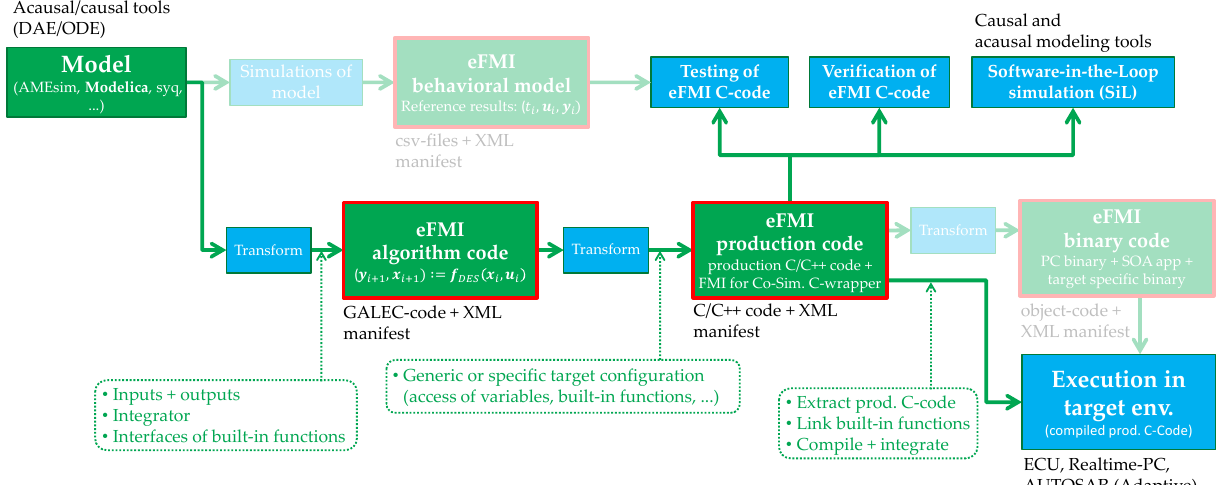
Figure 2. The eFMI workflow adapted from [11]. The highlighted path shows the workflow utilized in this work.